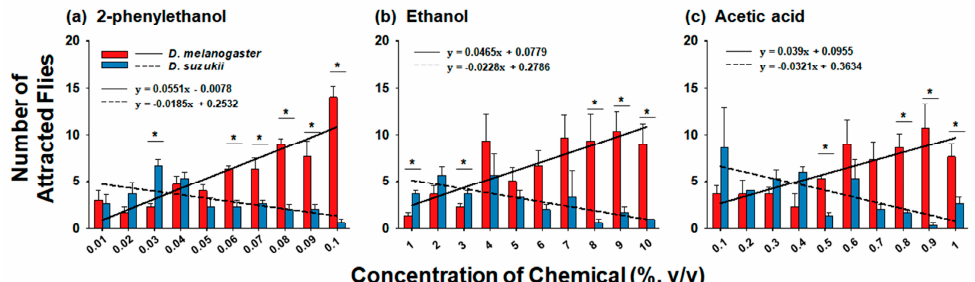
Figure 1. Comparison of the Y-tube choice behavior between Drosophila melanogaster and Drosophila suzukii to ( a ) 2-phenylethanol, ( b ) ethanol, and ( c ) acetic acid. Twenty flies were introduced into the entrance of the olfactometer, and the number of flies that entered the side arms was counted. At the given concentration of the chemicals, Student’s t -test was used to compare chemical preference between the two fly species. Asterisks indicate significant differences ( p < 0.05). The data are presented as the mean ± standard error.